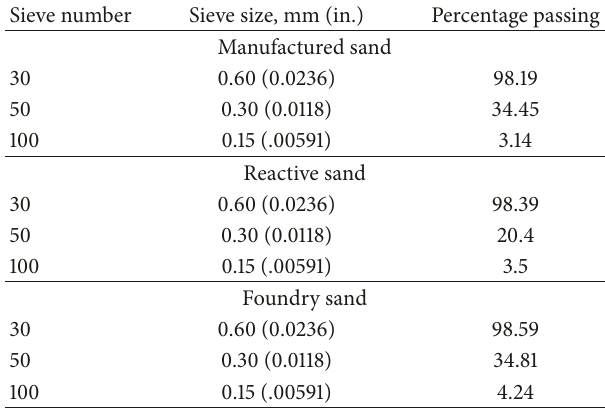
Table 3: Grain size distribution for the